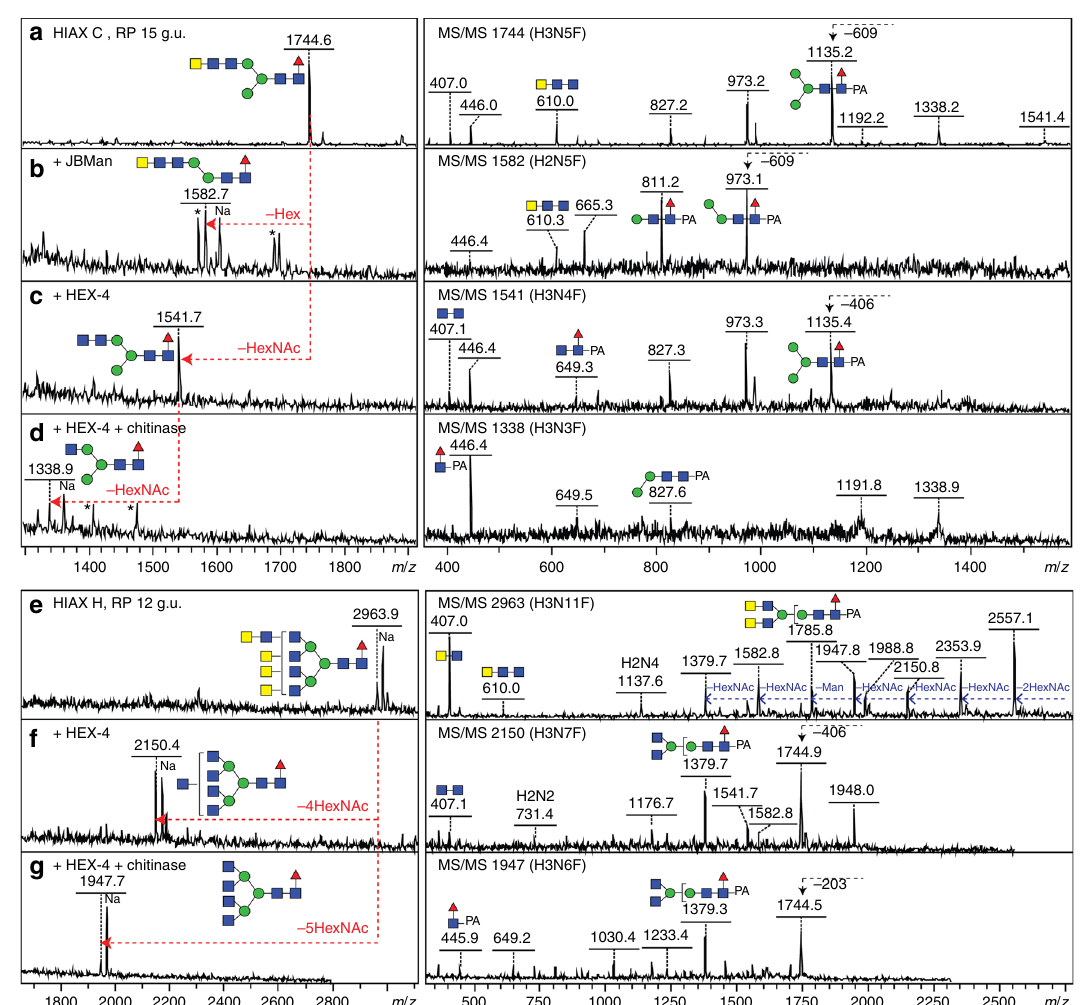
Fig. 2 Example glycosidase digestions of N-glycans with tri- and di-HexNAc motifs. Pyridylaminated Hex 3 HexNAc 5 Fuc 1 ( m / z 1744) and Hex 3 HexNAc 11 Fuc 1 ( m / z 2963) glycans isolated in different 2D-HPLC fractions (Fig. 1, HIAX C and H) were subject to positive mode MALDI-TOF – MS (left) and MS/MS (right) before ( a , e ) and after treatment with either jack bean α -mannosidase ( b ), C. elegans HEX-4 ( c , f ) or C. elegans HEX-4 followed by Streptomyces chitinase ( d , g ). Contaminant peaks in enzyme digests (B and D; m/z 1570, 1689, 1696, 1407 and 1476) are indicated by asterisks. The MS/MS spectra are annotated with selected B- and Y-ion fragments (the latter, e.g. m / z 446, 973 or 1176, containing the reducing terminal PA label with the possible structure for the selected fragments based on the assumption of a single fragmentation event) as well as relevant serial losses (indicated in blue) or a single loss of 203, 406 or 609 from the parent (i.e. HexNAc 1-3 ; indicated with black arrows); the loss of m / z 407 or 610 B-ions (HexNAc 2-3 ) upon HEX-4 or chitinase digestions are indicative of removal of antennal GalNAc or GlcNAc residues. As de fi ned by this and other data (including Supplementary Figures 6, 8 and 23, previous publications as well as controls with LacdiNAc and chitobiose-glycoconjugates and standard N-glycans), C. elegans HEX-4 is speci fi c for β 1,4- linked GalNAc and chitinase for either β 1,4-linked HexNAc. Thereby, the nature of the HexNAc 2 and HexNAc 3 motifs of the m / z 1744 and 2963